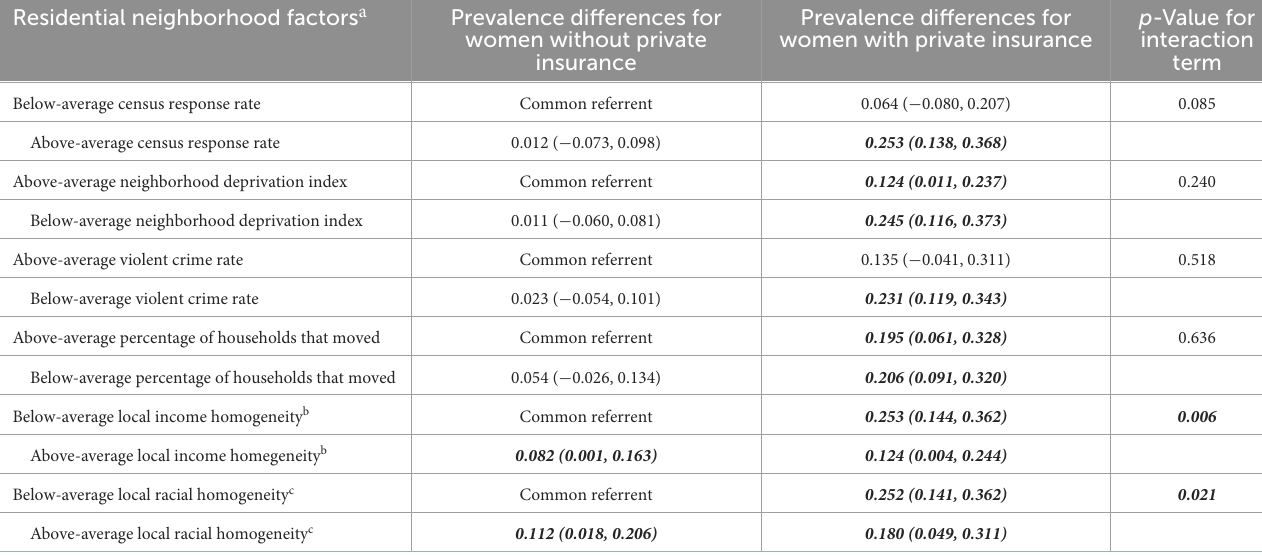
TABLE 3 Joint effects of maternal insurance type and residential neighborhood factors on prevalence of a Lactobacillus (non- iners )—dominant vaginal microbiome.